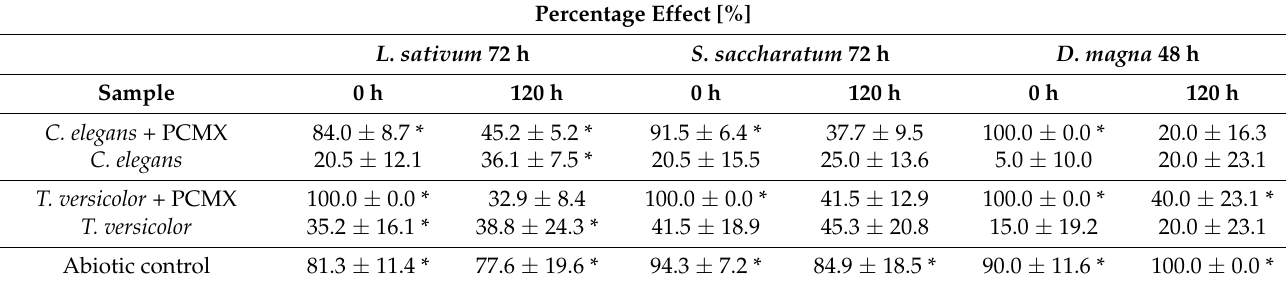
Table 2. Toxicity analysis of C. elegans and T. versicolor cultures with chloroxylenol in the Daphtoxkit F and phytotoxicity assays. Each result represents an average ± SD ( n = 4). Statistical analysis was performed using the Mann–Whitney U test with * p <